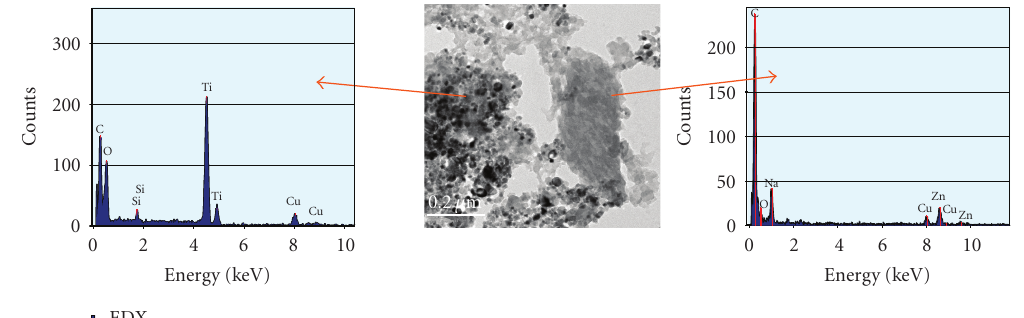
Figure 4: Transmission electron micrography and X-ray dispersive energy of the composite containing 5% of ZnPc.